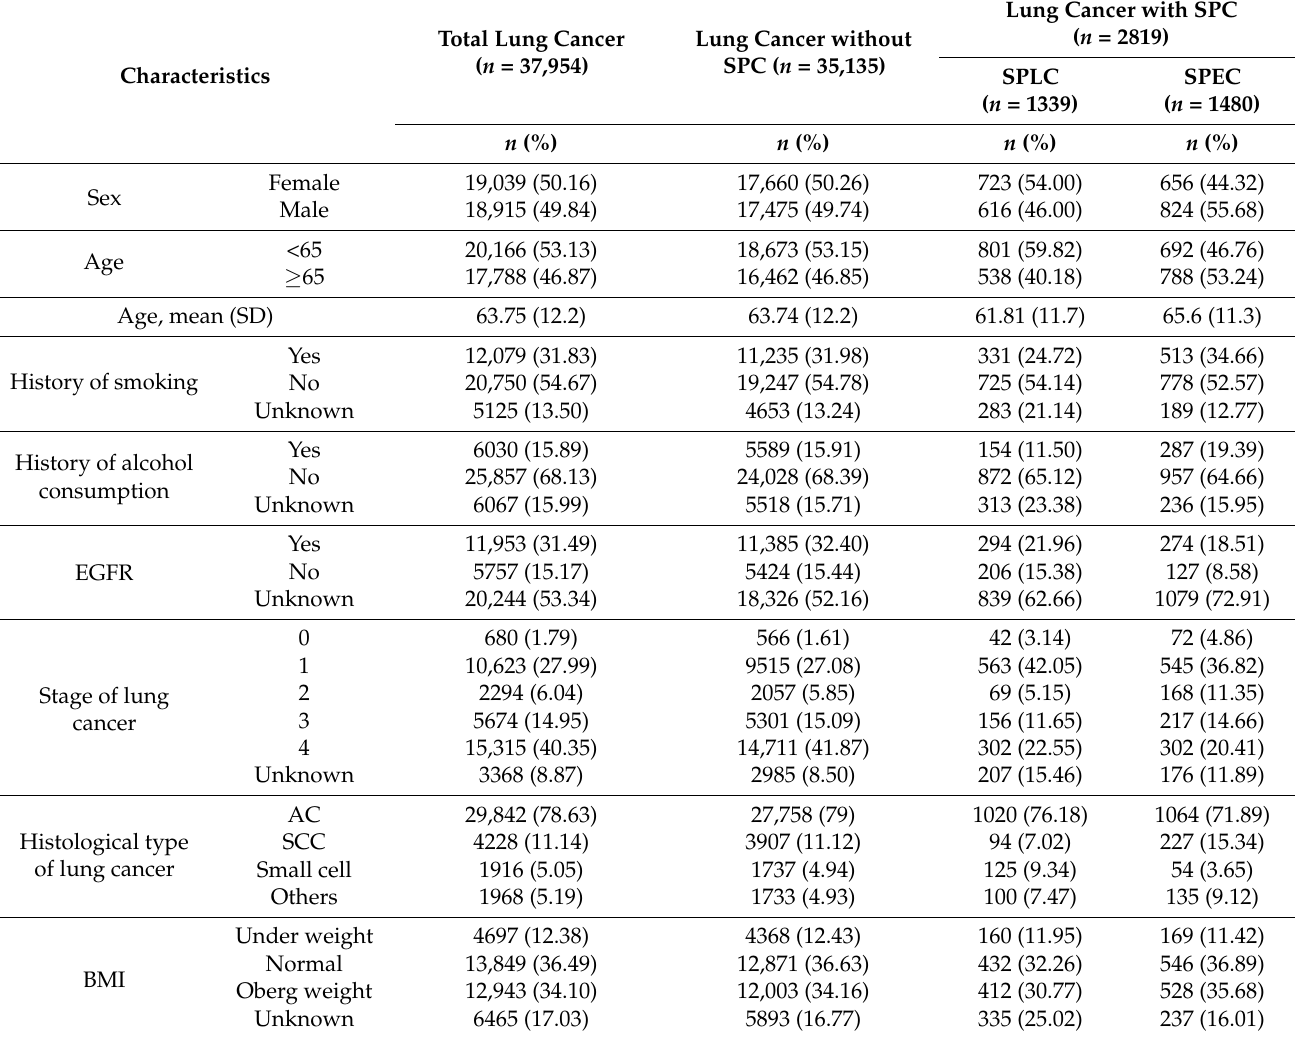
Table 1. The baseline characteristics of patients with lung cancer with and without SPCs (SPLC and SPEC groups,